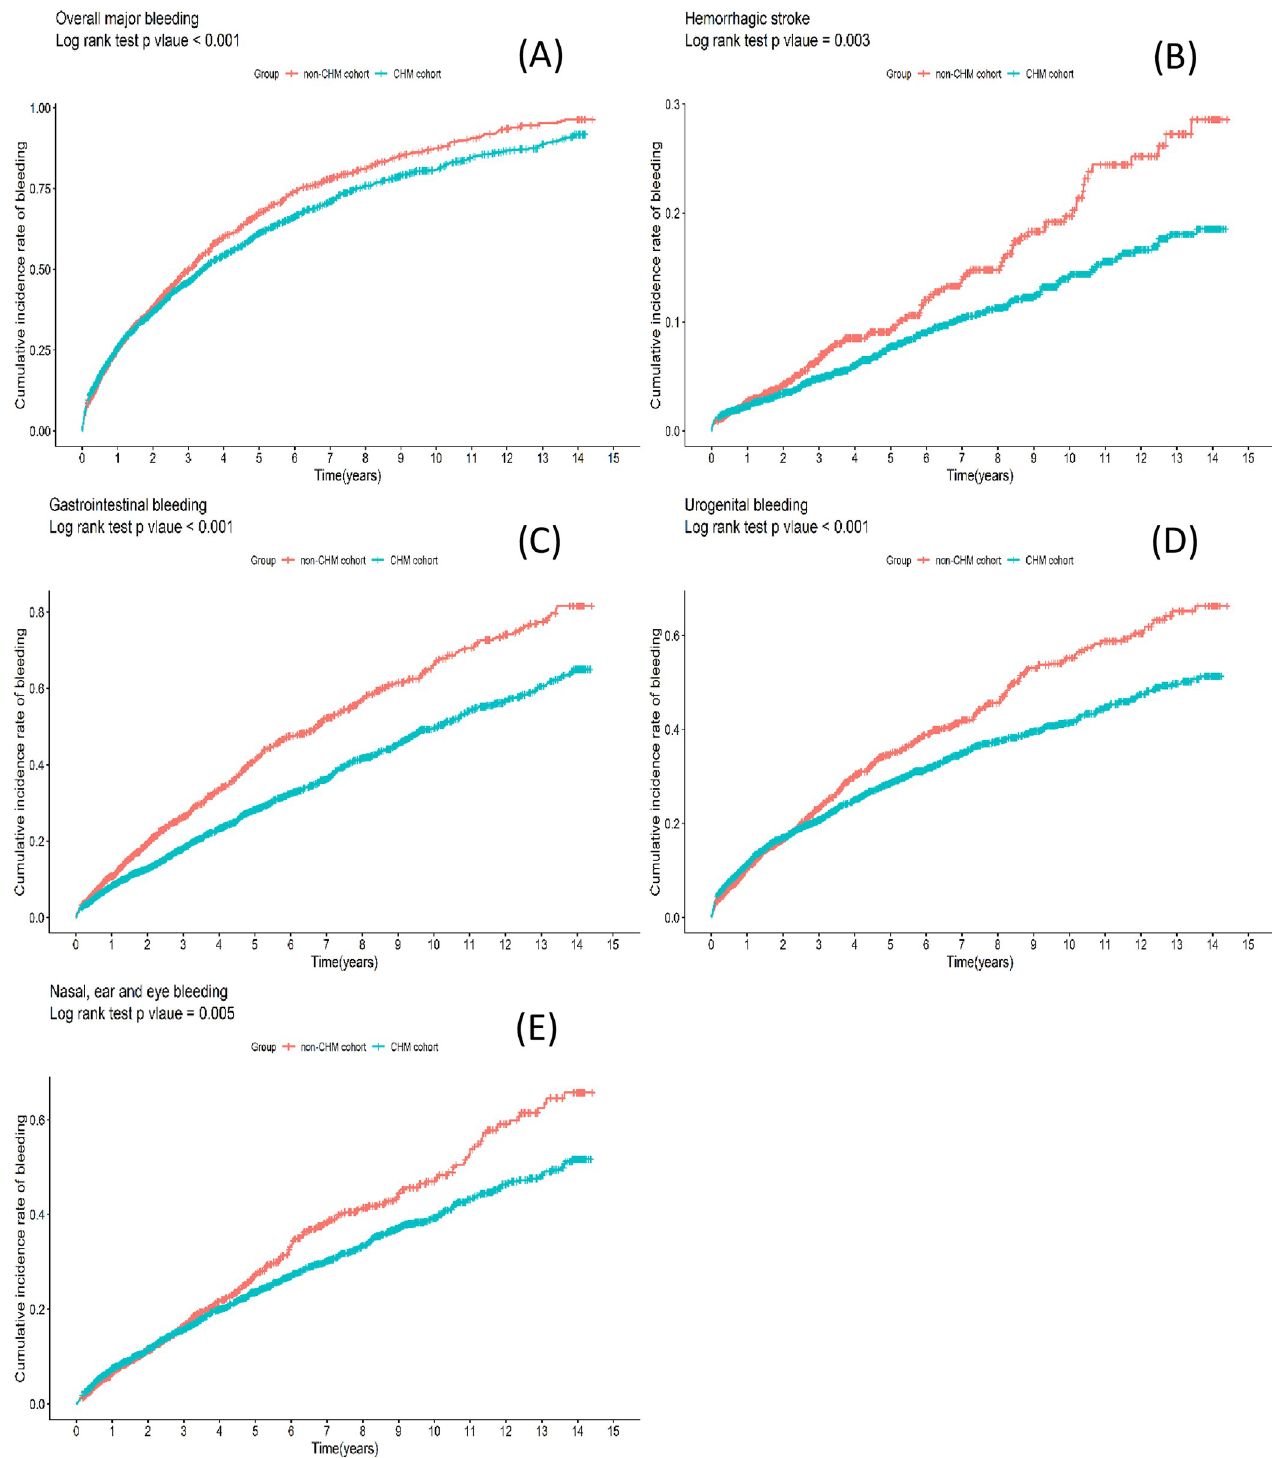
Fig 2. Kaplan–Meier analysis showing cumulative incidence of major bleeding events included (A) overall bleeding, (B) hemorrhagic stroke, (C) gastrointestinal bleeding, (D) urogenital bleeding and (E) nasal, ear, and eye bleeding for both CHM and non-CHM cohorts during a 15-year follow-up.